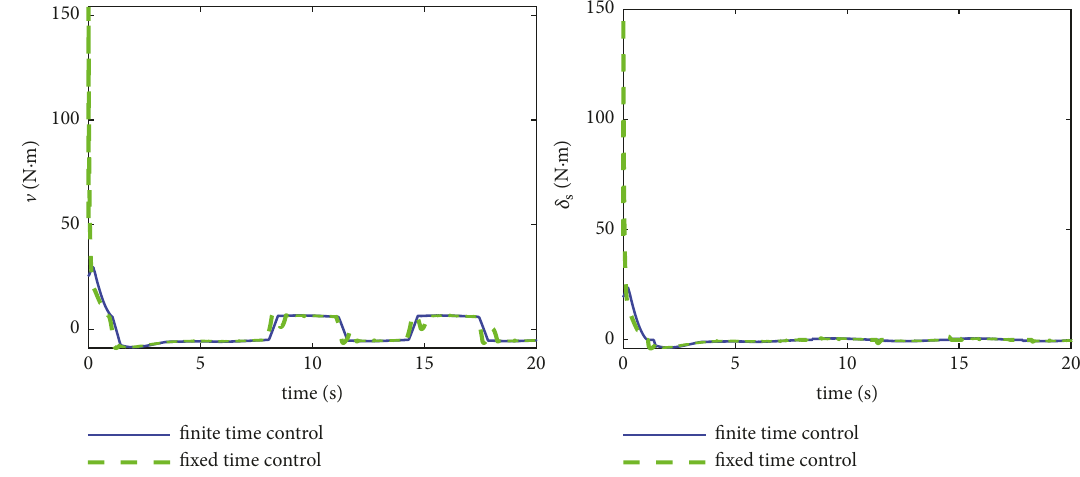
Figure 9: The control input V and 𝛿 𝑠 for the case of existing dead-zone input in two methods for comparisons.